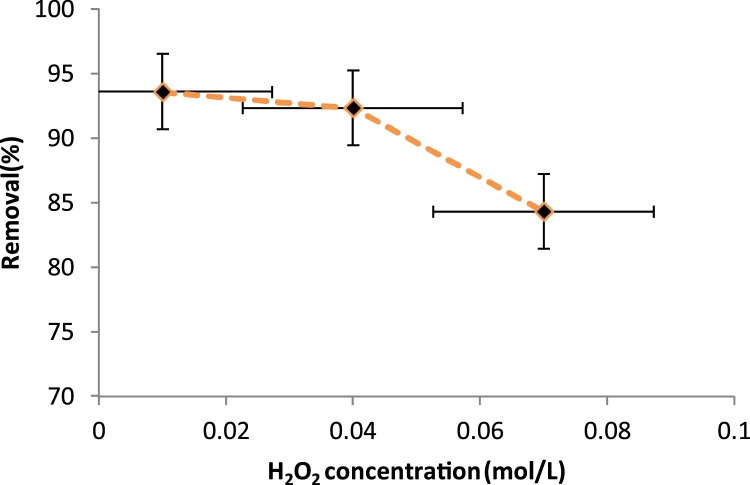
Effect of H2O2 concentration on the removal efficiency of aniline (Time: 45 min, aniline concentration: 20 mg/L, pH: 3).